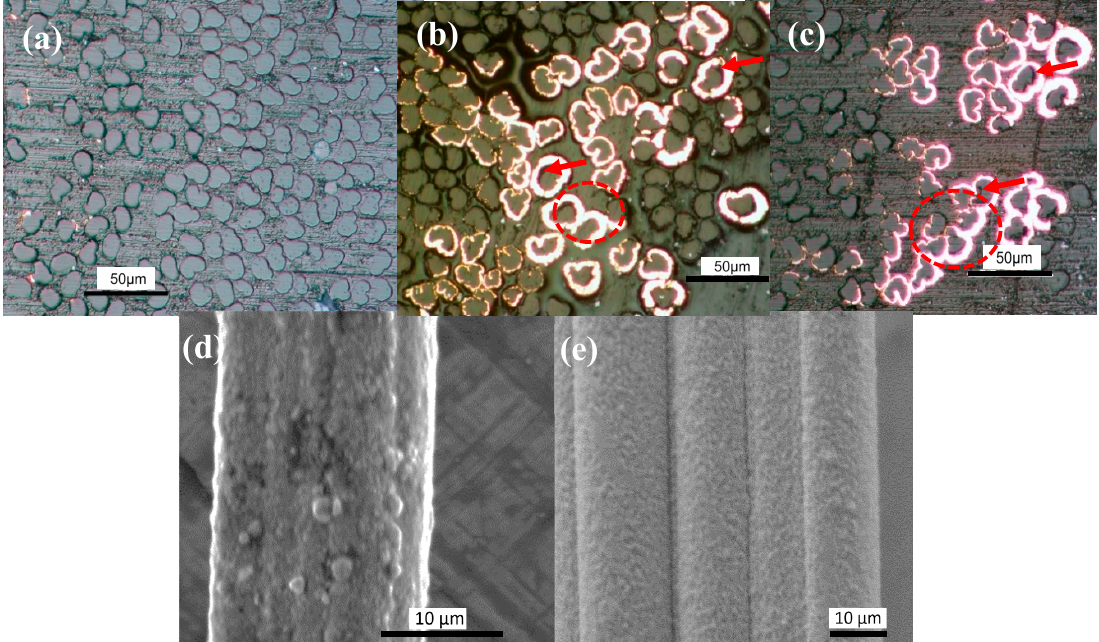
Figure 1. Optical micrographs (OM) of the cross-sections (top) and JEOL JCM-6000 Neoscope scanning electron microscope (SEM) images of the fiber surface (bottom) of ( a ) coated fibers after 15 min, ( b , d ) 60 min, and ( c , e ) 90 min immersion time in a Cu-plating bath.